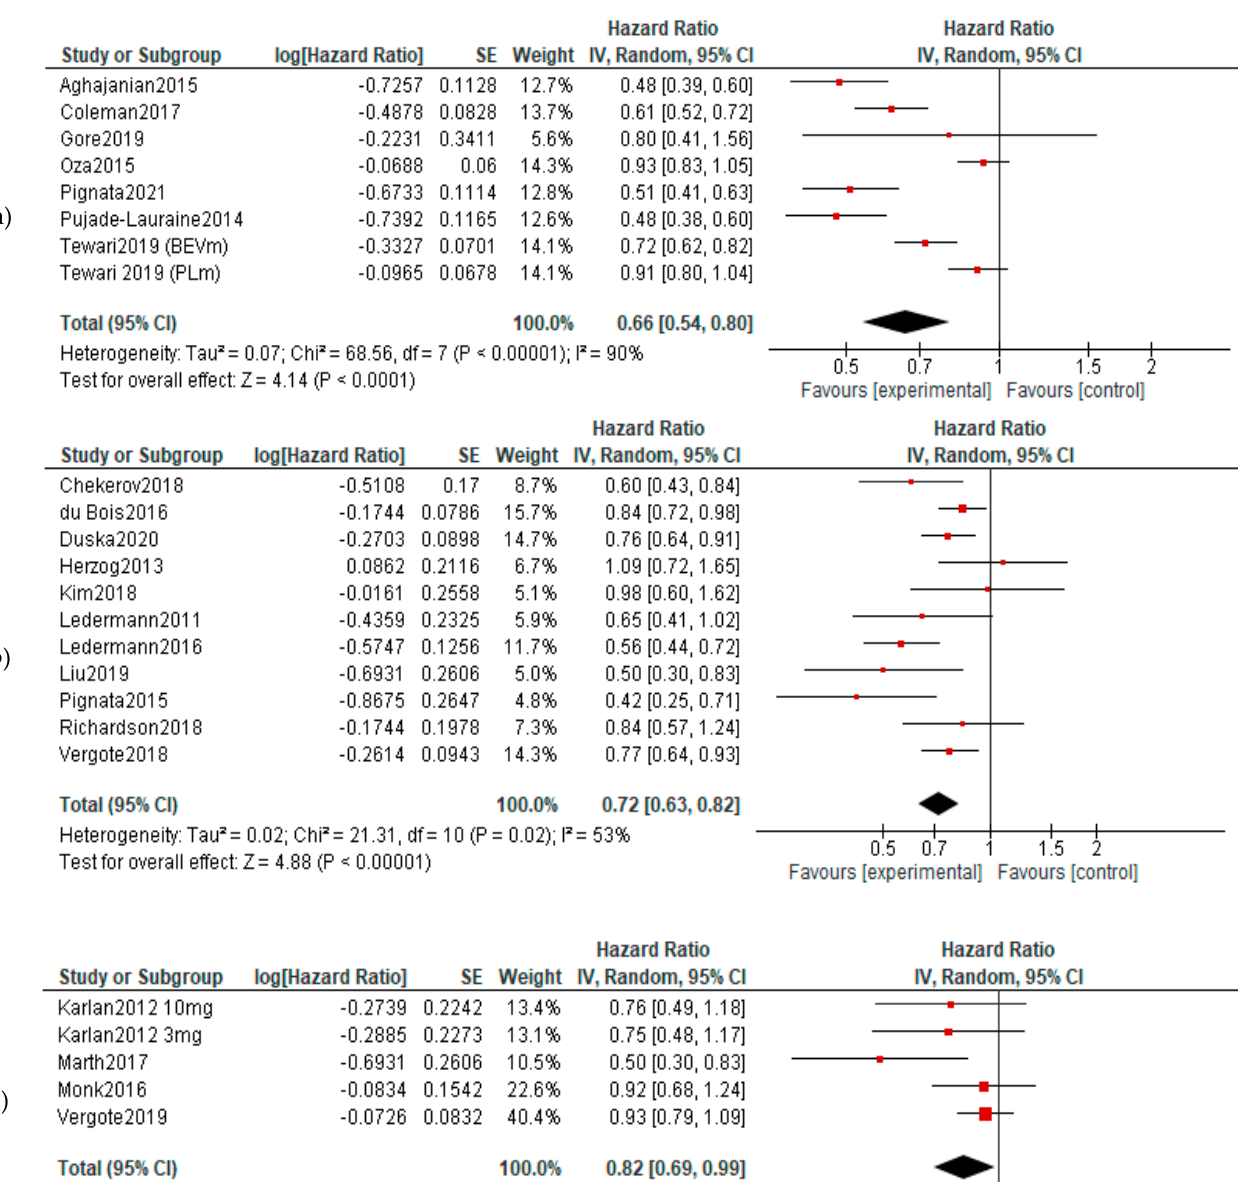
Figure 4. Settings subgroup analysis of overall survival: ( a ) first line, ( b ) recurrent, ( c ) P-S R, ( d ) P- R R and ( e ) maintenance. The black diamonds are visual representations of the pooled effect and its confidence intervals and are non-significant if they overlap 1. Red squares represent each study effect size and study weight size of square). The lines represent each study confidence interval.